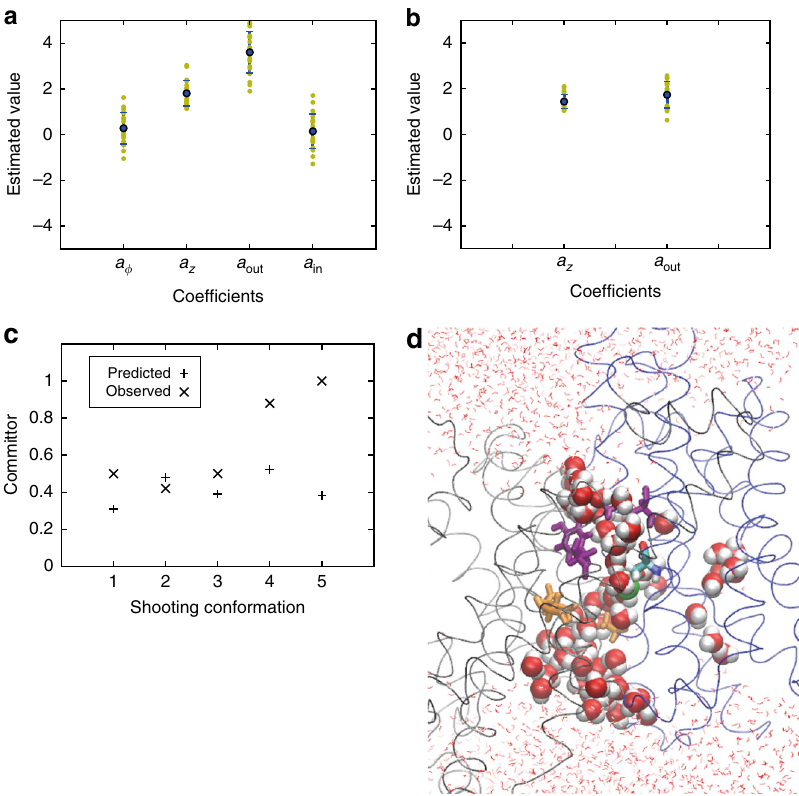
Fig. 4 Reaction coordinate optimization. a Estimated coef fi cients for four order parameters: angle and z-translation of the domain motion, and pair distances resolving opening and closing of the hydrophobic gate (Ile163-Tyr255) and the intracellular residue pair Ile69-Ala132. The likelihood calculated from shooting data for 16 shooting points was used in the optimization. b Estimated coef fi cients for two order parameters: z-translation of the domain motion and distance of the gate residues. Shooting data from 21 shooting points were used in the likelihood maximization. Error bars in ( a ) and ( b ) represent s.d. of the estimated coef fi cients. c Predicted committor values using the optimized reaction coordinate are compared to the observed committor values from the third round of shootings following the second initial path. d A shooting conformation that successfully produced transition paths (shooting conformation 2 in c ; same graphic representation as in Fig.